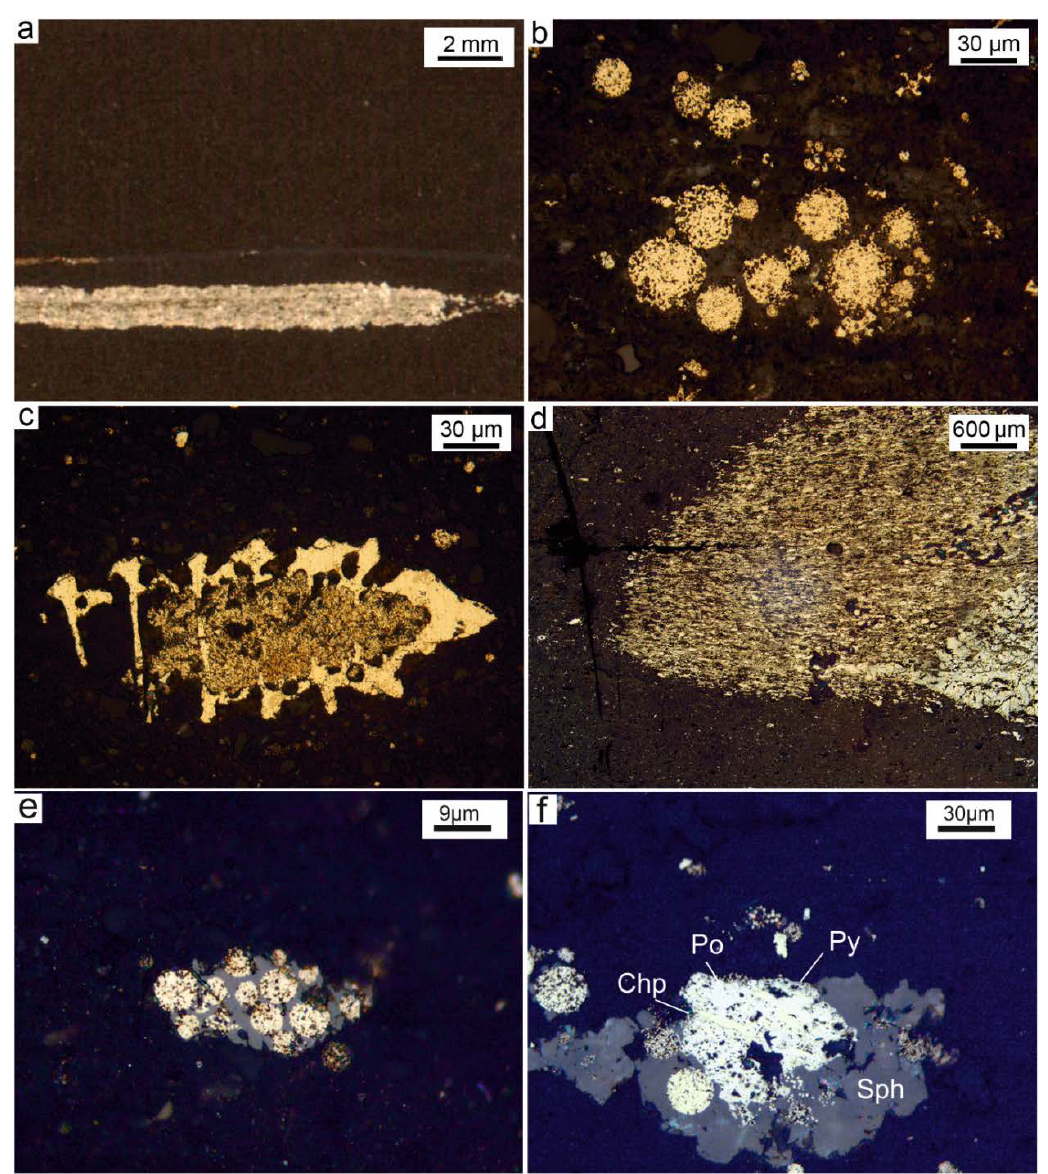
Figure 2. Pyrite varieties from black shales of the Bazhenov Formation. ( a ) pyritized nodule-like bituminous layers in in black shales; ( b ) framboidal pyrite in carbonaceous shale; ( c ) framboidal pyrite in a cavity of radiolarian pyrite pseudomorph; ( d ) nodule-like pyrite with laminated mat-related structure in black shale; ( e ) framboidal pyrite cluster cemented by sphalerite; ( f ) micro-inclusions of framboidal and fine-grained pyrite (Py) by chalcopyrite (Chp) and pyrrhotite (Po) in sphalerite (Sph) aggregate. Reflected light.